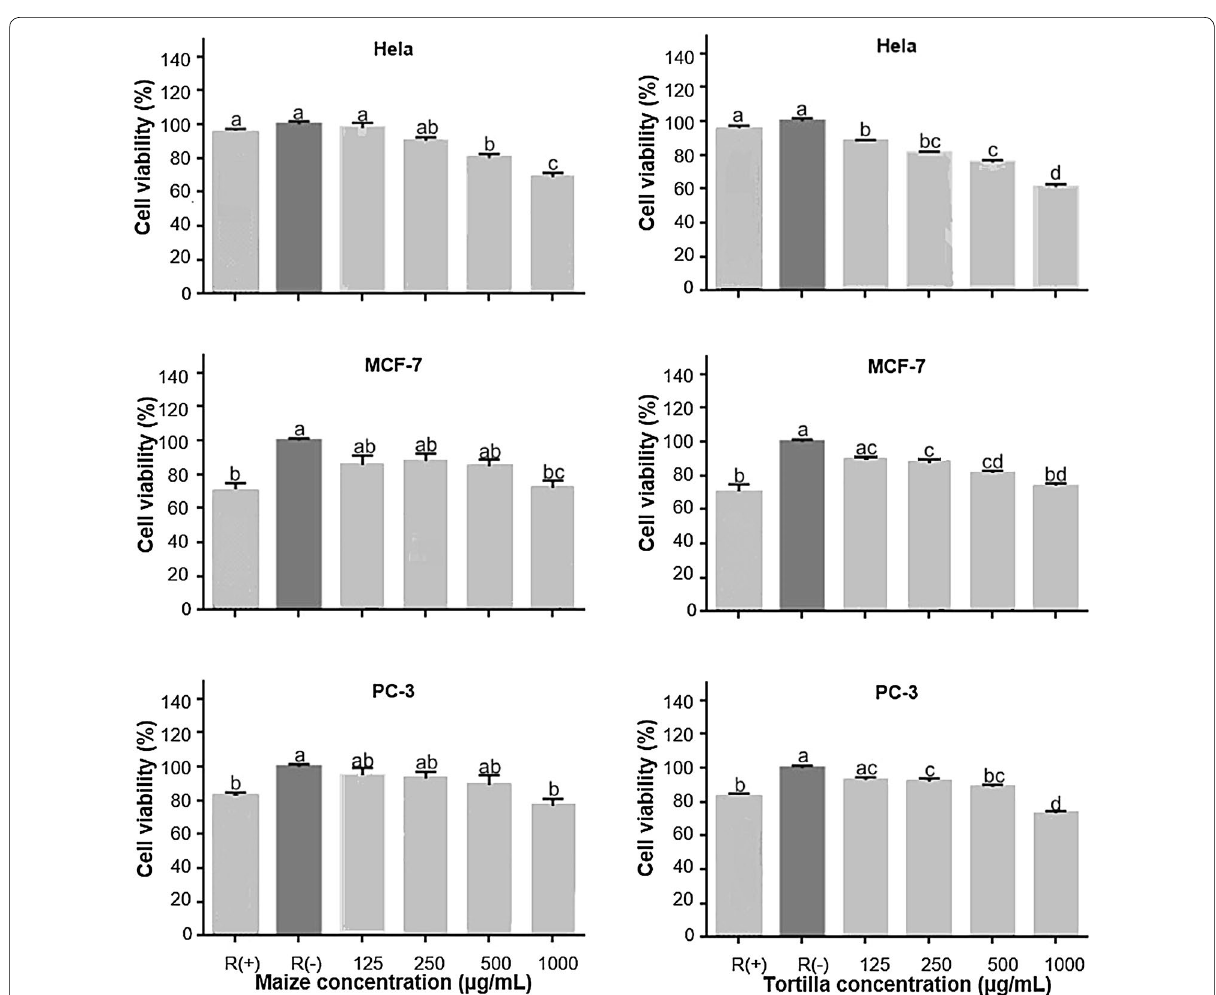
Fig. 3 Effect of blue con and tortilla extracts on cell viability in Hela, MCF‑7 and PC‑3 human cancer cell lines. R ( medium. Different letters indicate that there are significant differences (p